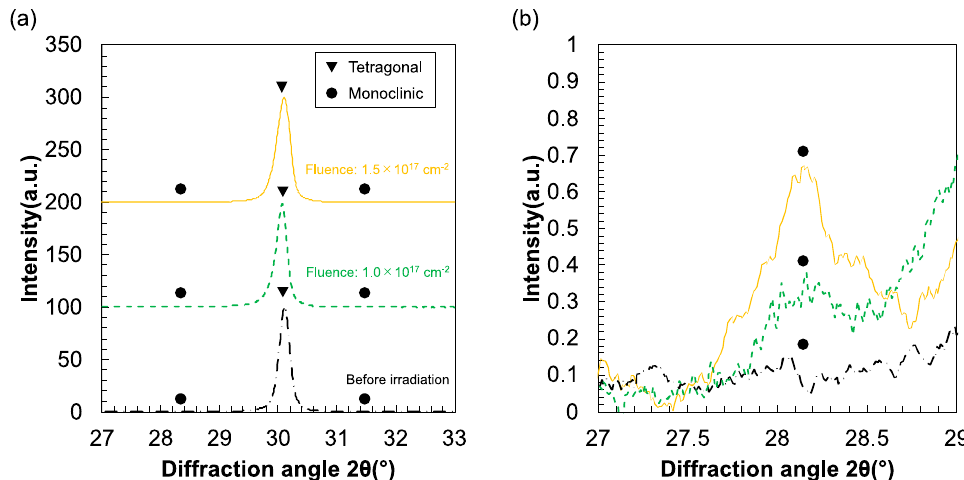
Figure 1. XRD patterns of a PSZ specimen before and after irradiation with 100 keV electron beams. The black line is before irradiation. ( a ) is the spectrum of the measured range shifted up by 100; ( b ) is the spectrum focused on m (11 − 1) between 27 and 29°.